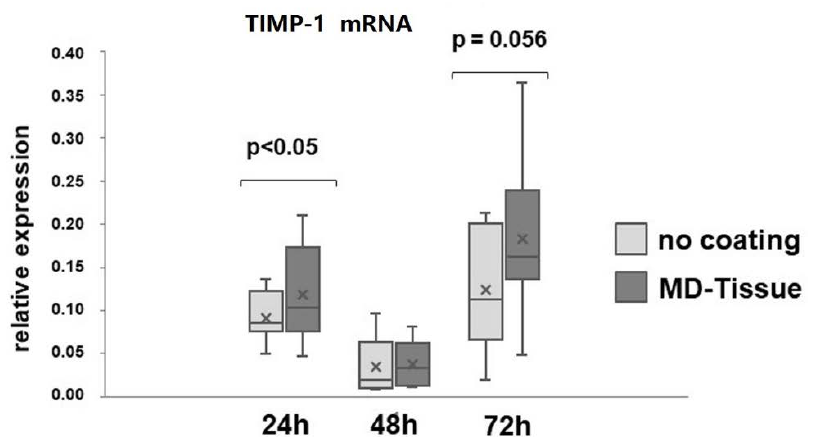
Figure 6. Bar graphs showing tissue inhibitor of matrix metalloproteinase-1 (TIMP-1) gene expression after normalization on GAPDH mRNA levels. Data obtained from the eight samples are expressed as mean ± SD. × :